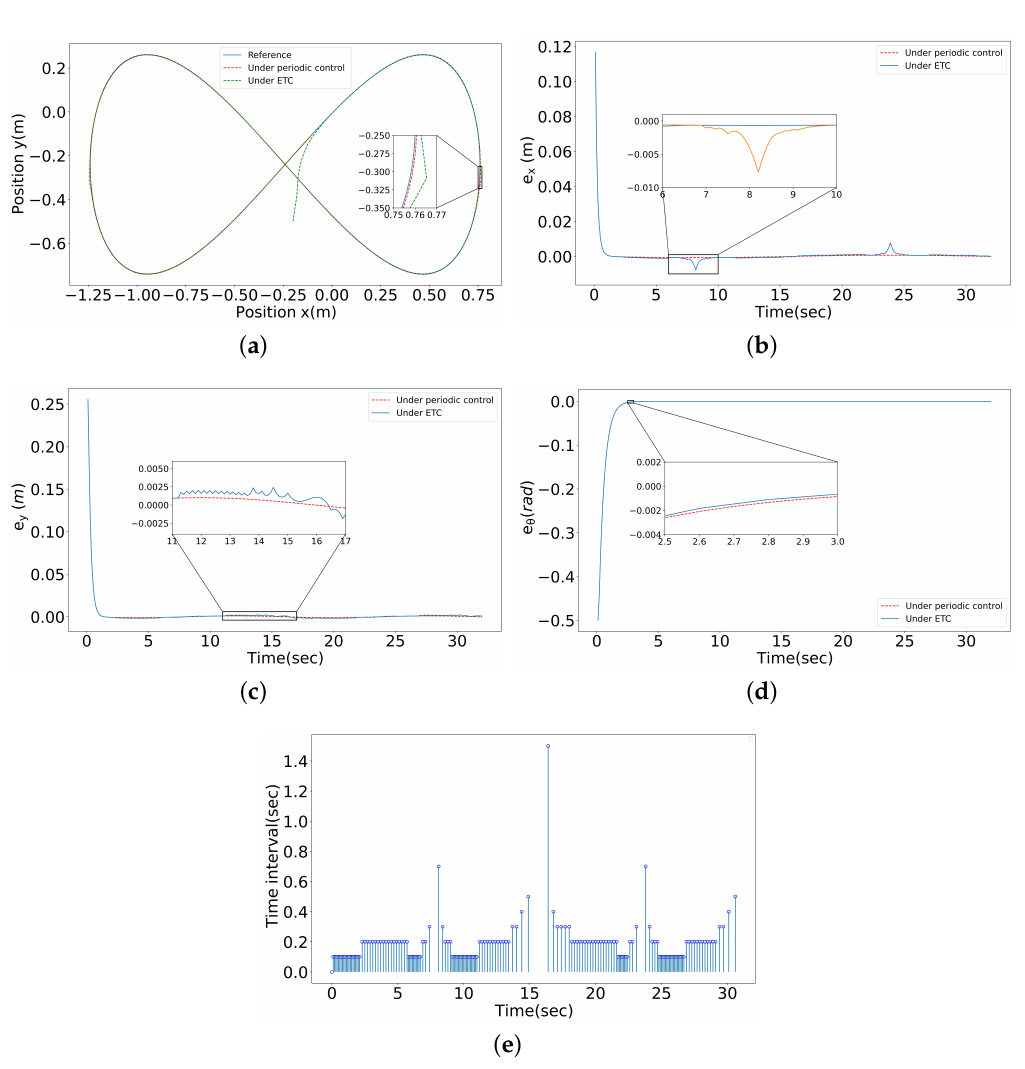
Figure 7. Simulation results by different control methods. ( a ) Trajectory tracking status. ( b ) Pose error, e x . ( c ) Pose error, e y . ( d ) Pose error, e θ . ( e ) Triggering